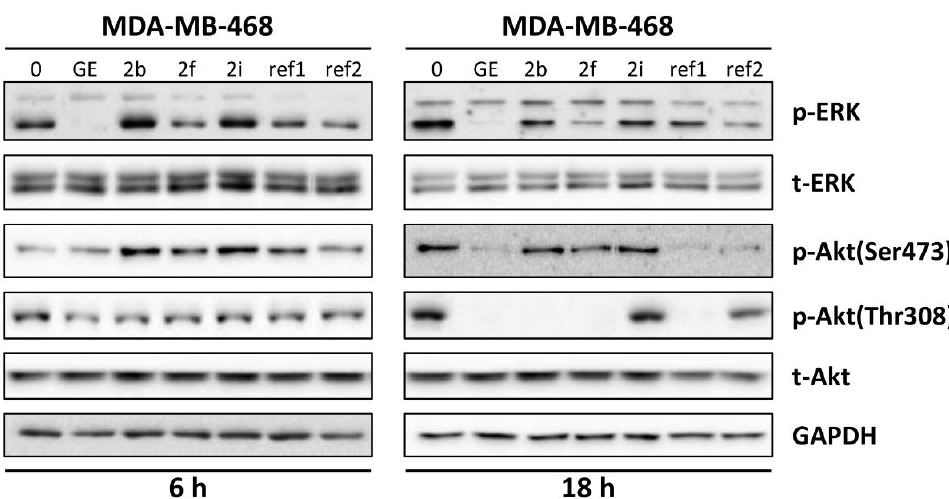
Figure 4. The effect of the compounds on EGFR signaling pathway in MDA-MB-468 cells. Cells were treated with 10 μM of gefitinib (GE), compound 2b , 2f , and 2i for 6 h and 18 h, respectively. Protein expression of phospho-ERK, total-ERK, phospho-Akt(Ser473), phospho-Akt(Thr308) and total-Akt were detected by immunoblotting. GAPDH was used as a loading control.